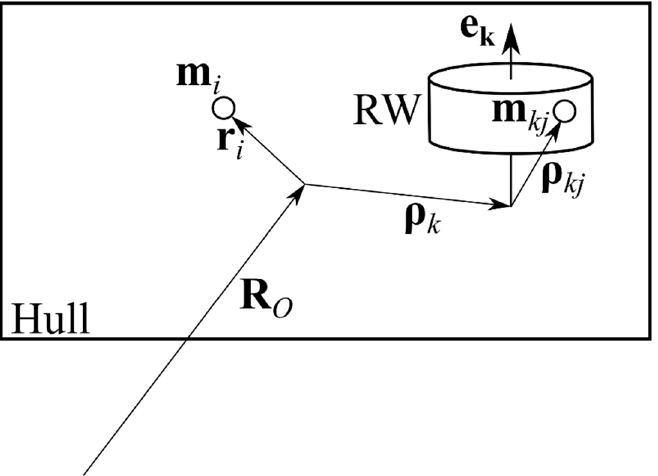
Figure 2. Spacecraft and reaction wheel.